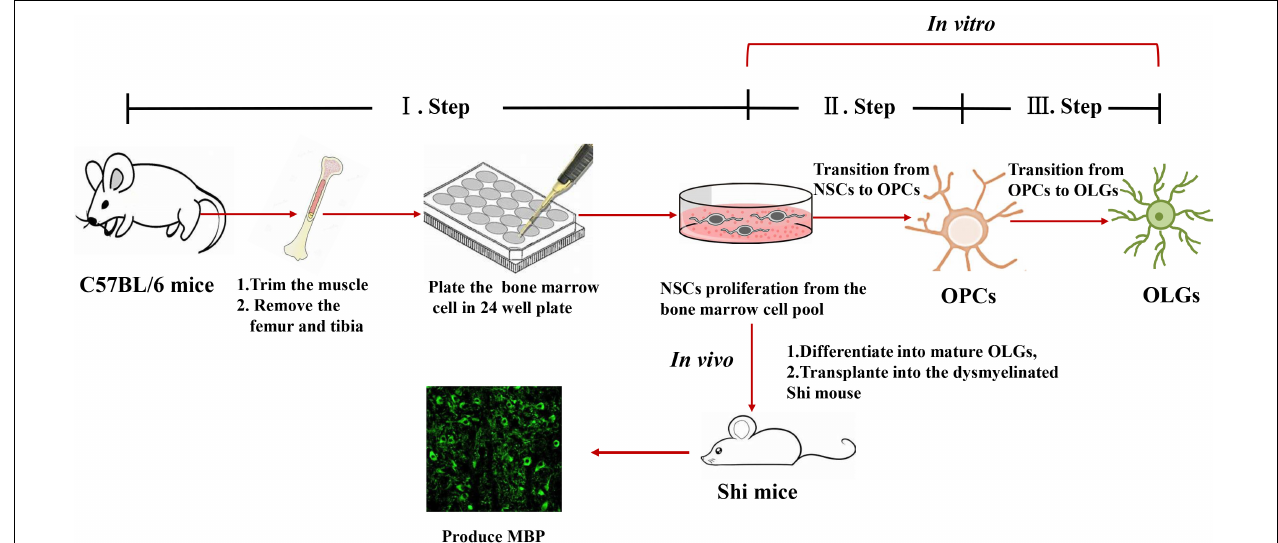
FIGURE 6 | Representative scheme of the protocol for generating OPCs and OLGs from autologous mouse bone marrow-derived